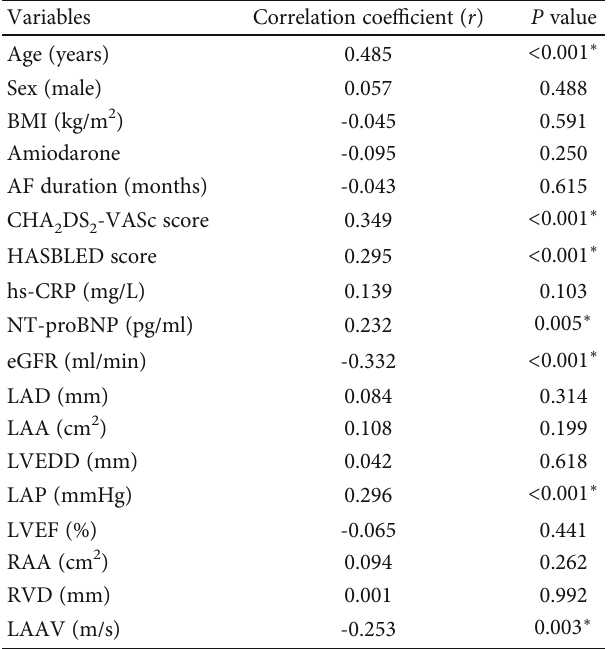
Table 3: Relationship between GDF-15 and Other